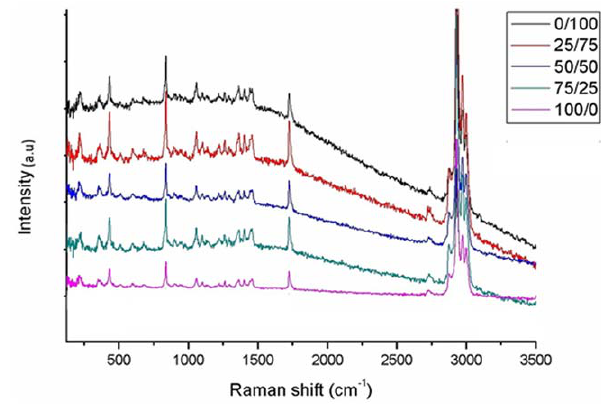
Figure 3. Raman spectra of PHB/PHBV nanofibers in different blend compositions.